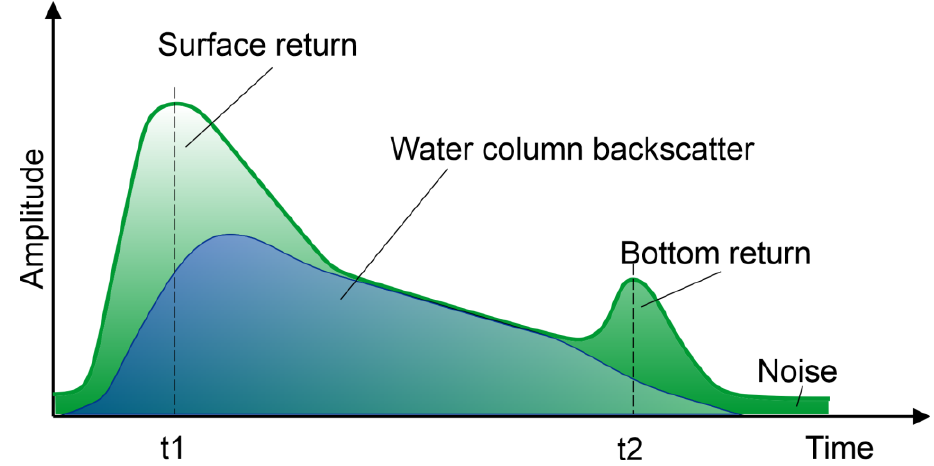
Figure 4. Schematic green LiDAR waveform showing the three principal signal